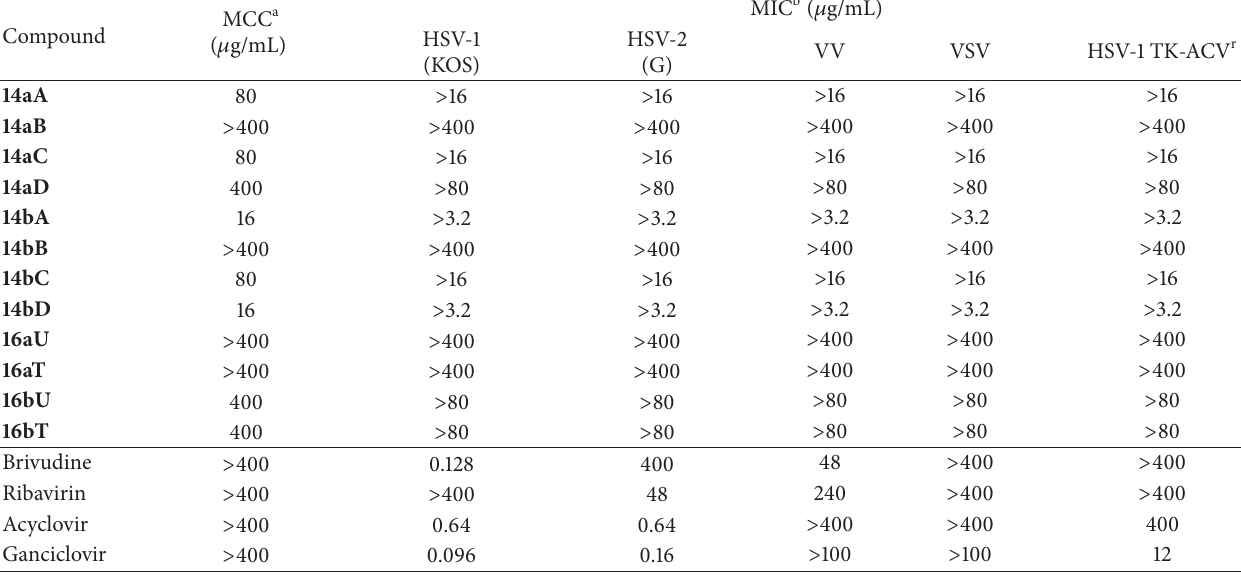
Table 2: Cytotoxicity and antiviral activity of compounds 14a,b and 16a,b in HEL cell cultures. Compound